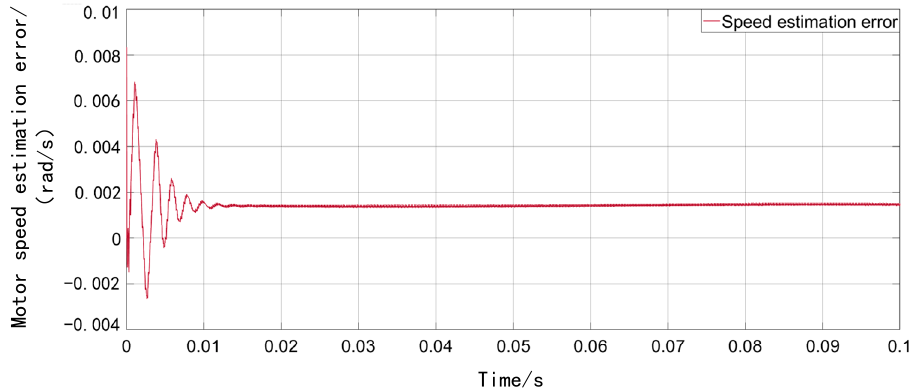
Figure 14. The variation curve of the new and improved SMO speed estimation error at low speed.